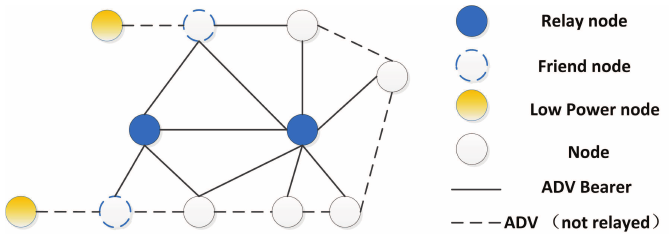
Figure 1. Bluetooth Low Energy Mesh network